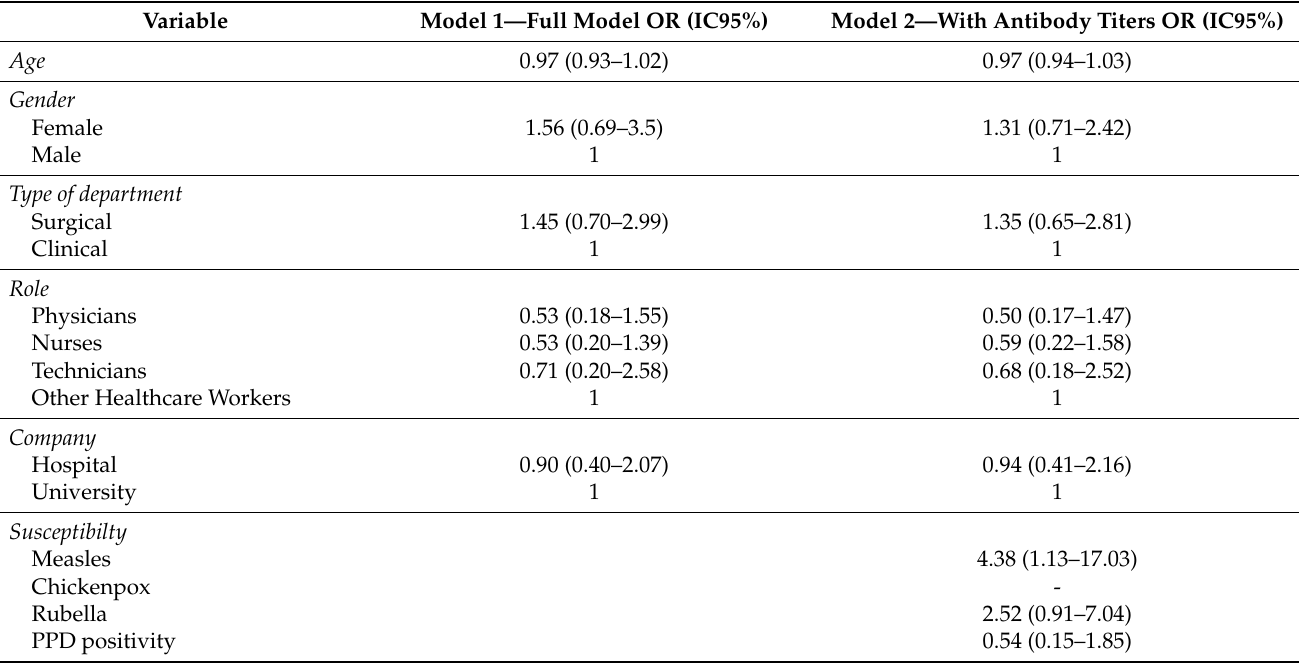
Table 6. Logistic regression analysis, dependent variable: chickenpox